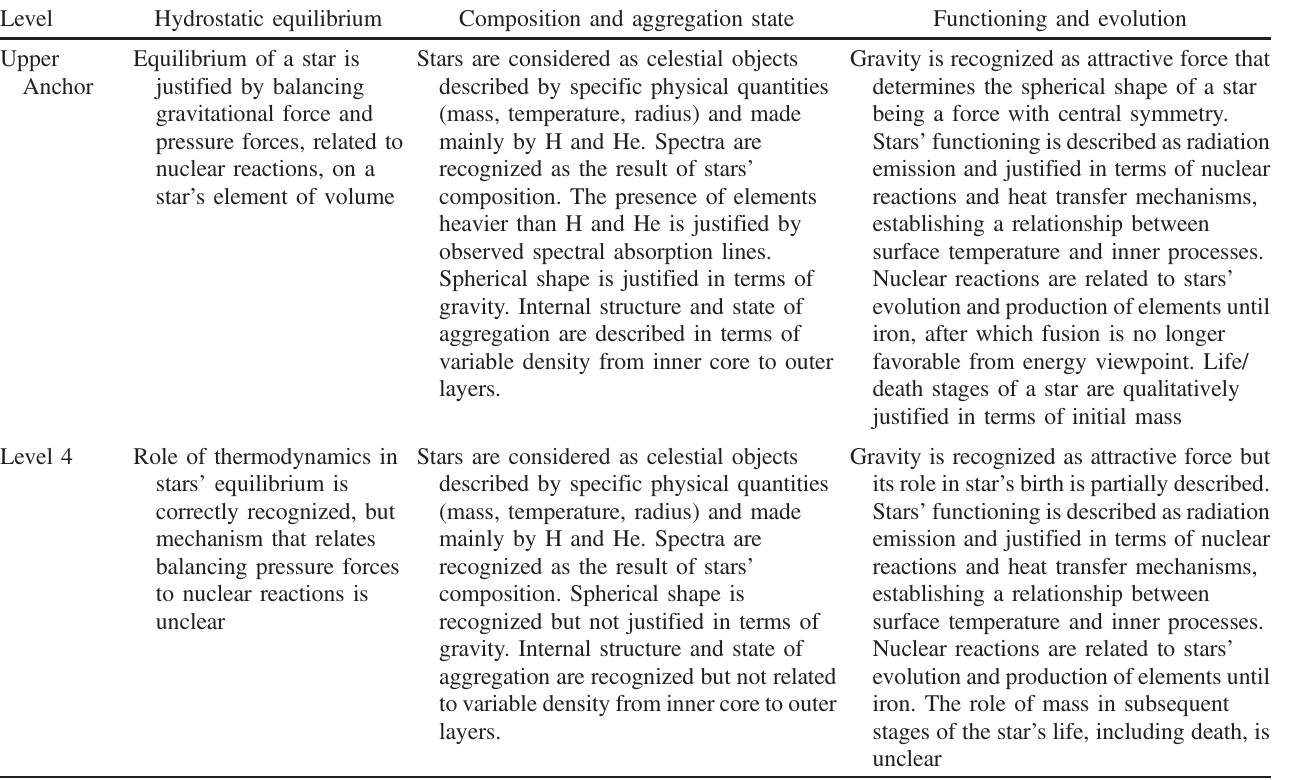
S124: “ well … Electrons jump between atomic levels